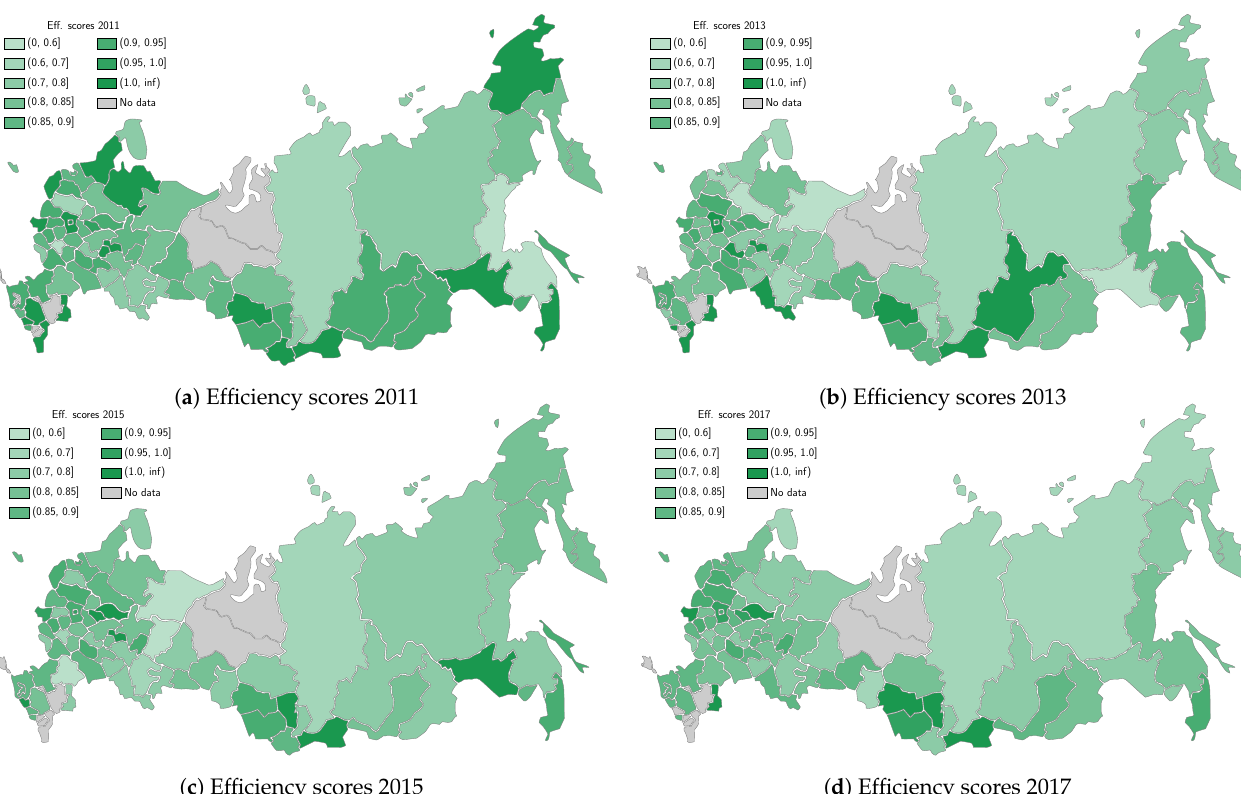
Figure 1. Spatial distribution of CCR-AR model results.